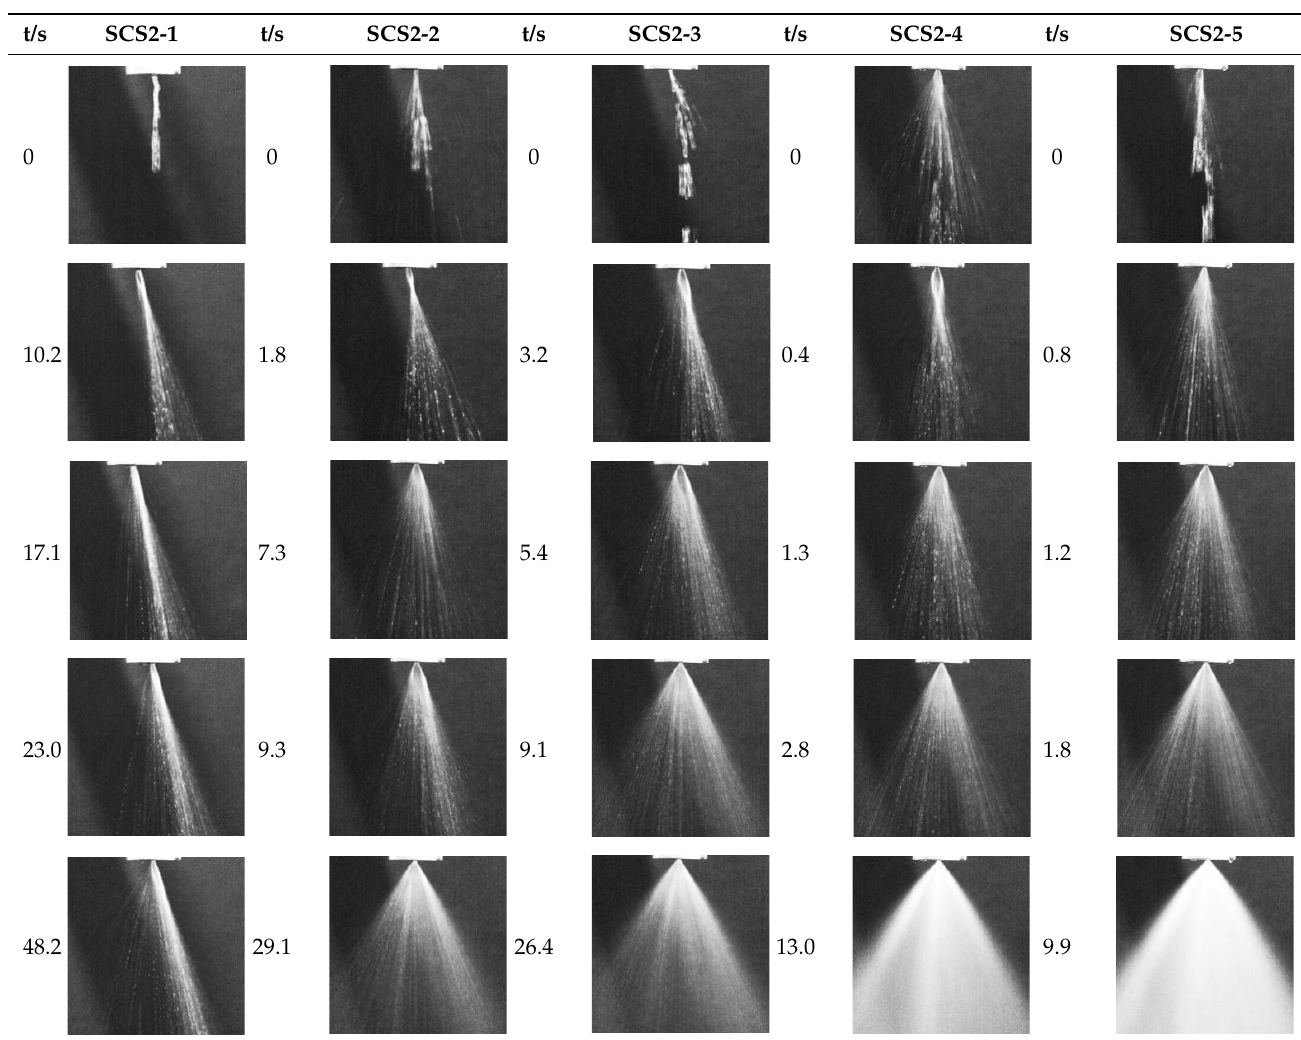
Table 6. Atomization process images of SCS2-injector.